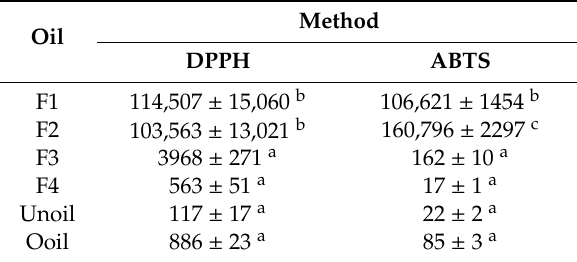
Table 4. Inhibition concentration (IC 50 ) mg /